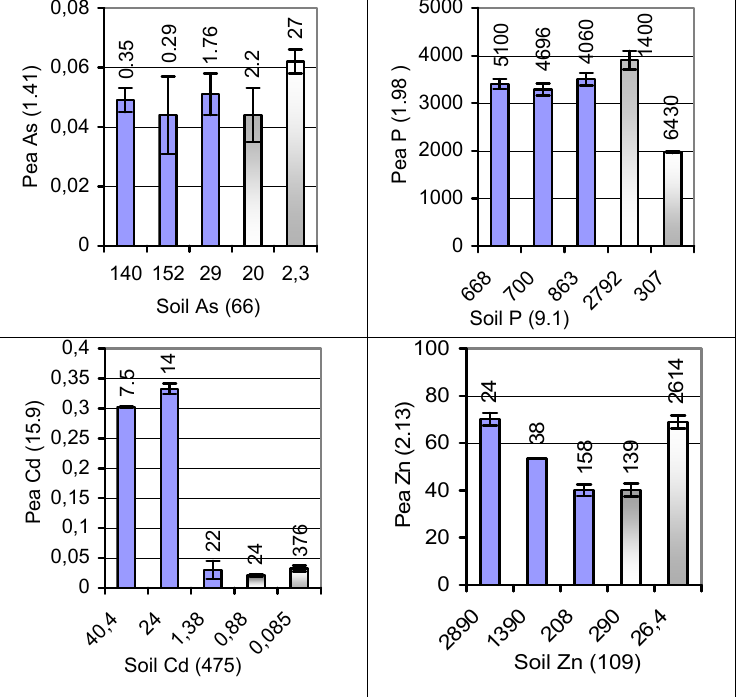
Figure 6. Incorporation of the chemically similar elements As/P and Cd/Zn in pea seeds. Up ‐ regulations of the seed:soil TFs (values heading the columns × 10 − 3 ) on low ‐ concentrated soils (mg kg − 1 DW) indicate the active acquisition of both essential and non ‐ essential elements. Differences in TFs and in the quotients of TF: soil concentrations indicate the safe discrimination of chemically similar elements. Concentrations in AsCdPZn represented by the bars are given in mg kg − 1 DW. Adapted from primary data of Gramss and Voigt [18].